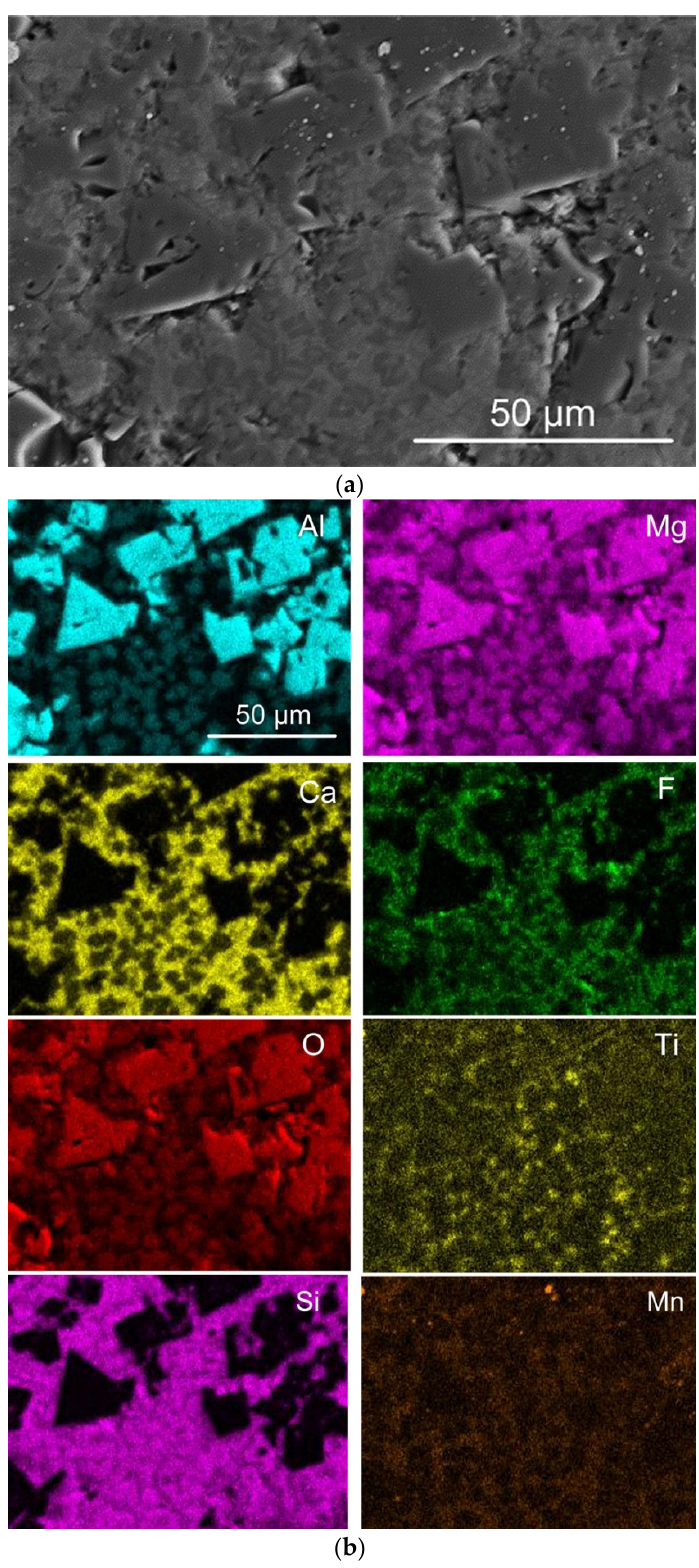
Figure 6. ( a ) BSE image of a smaller area in MP3 slag sample. ( b ) EDX map of slag area in Figure 6a: MP3 slag.